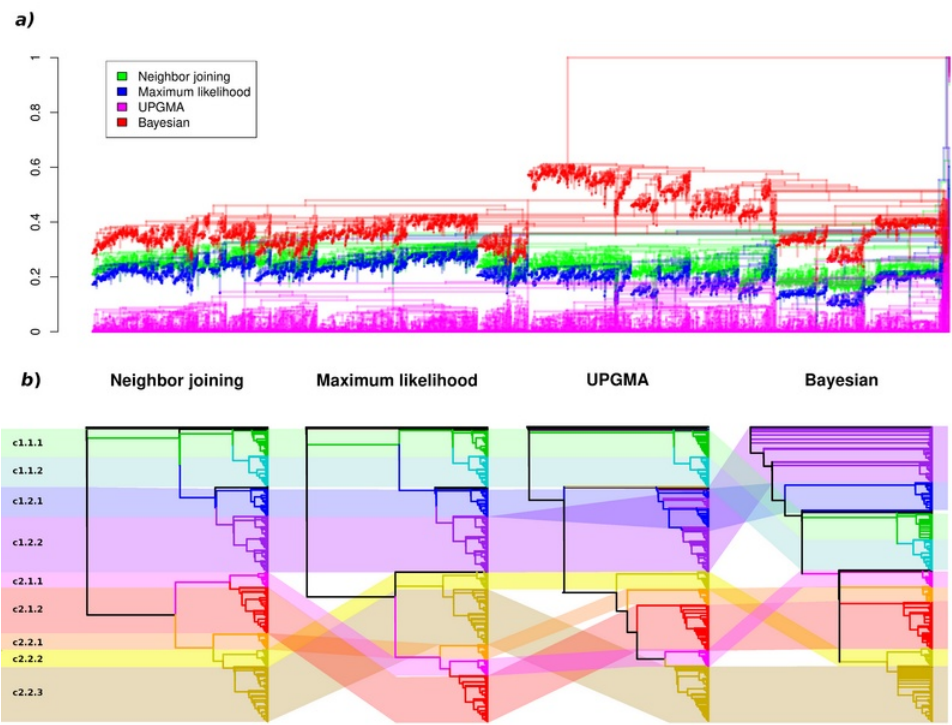
Figure 3. A comparison of the phylogenetic trees obtained using four different methods: ( a ) a superposition of the four aligned trees; ( b ) the consistency of the global topologies of the four trees. Table 2. The distribution of the MLO homologue identifiers provided by the NCBI database within the identified phylogenetic clades.